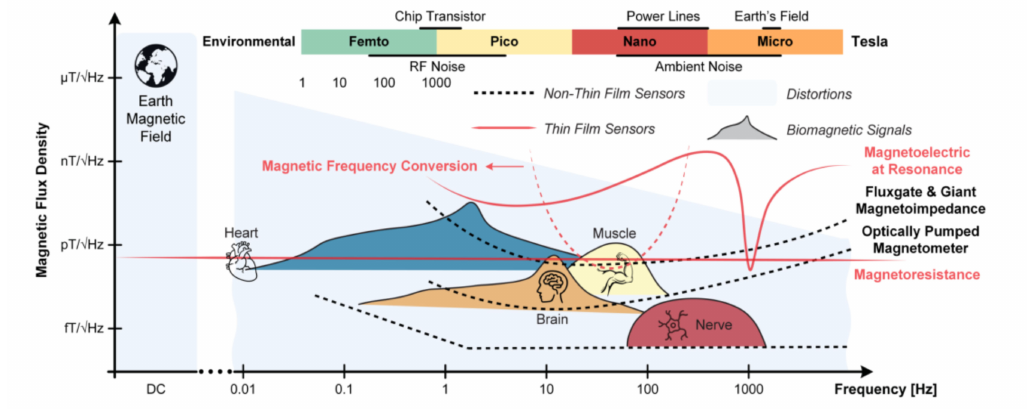
Figure 16. Amplitude densities of magnetic signals generated by various sources of the human body